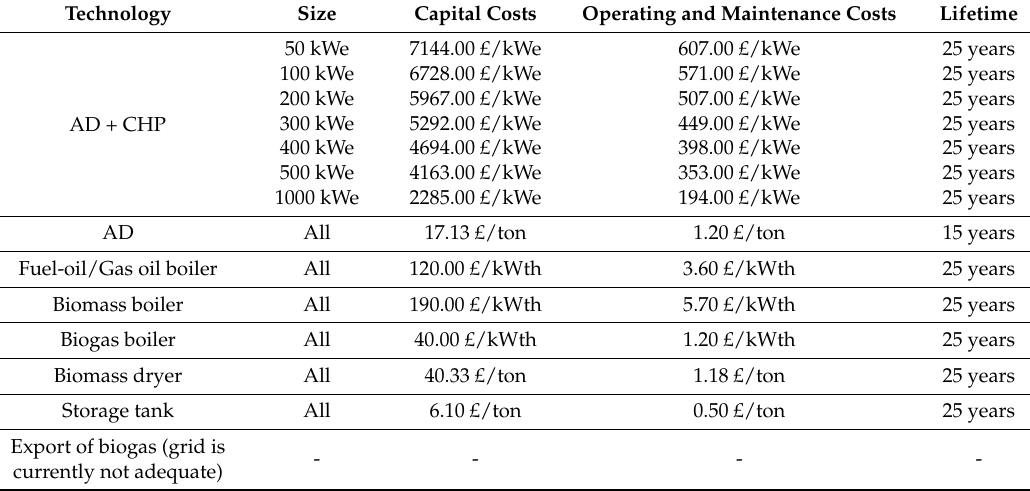
Table 8. Characteristics of technologies used in this study